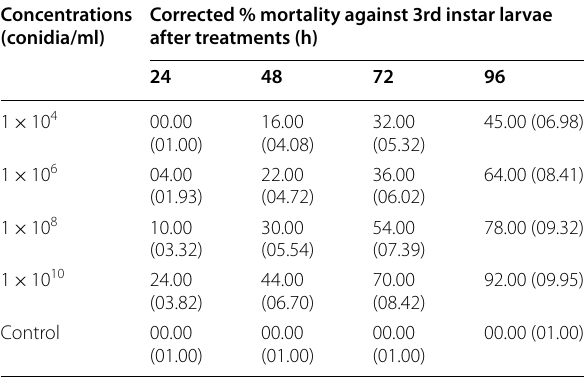
Figures in parentheses are transformed values (arc sine transformation) CD ( P 0.05) = Table 6 Pathogenic potential of Bacillus thuringiensis against 3rd instar larvae of Spodoptera litura under laboratory conditions